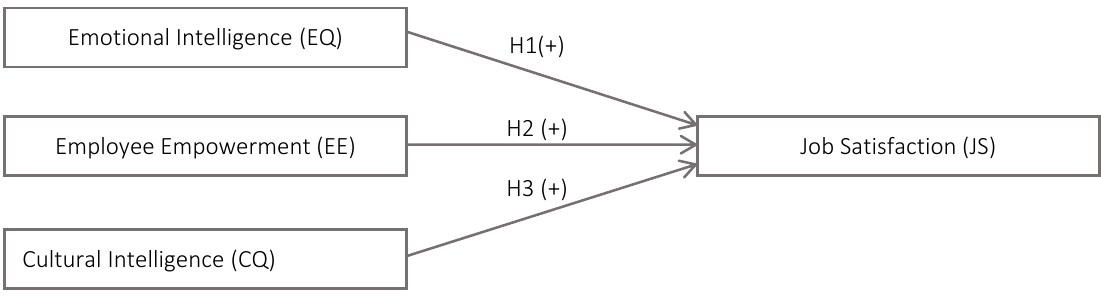
Figure 1. Research model of the